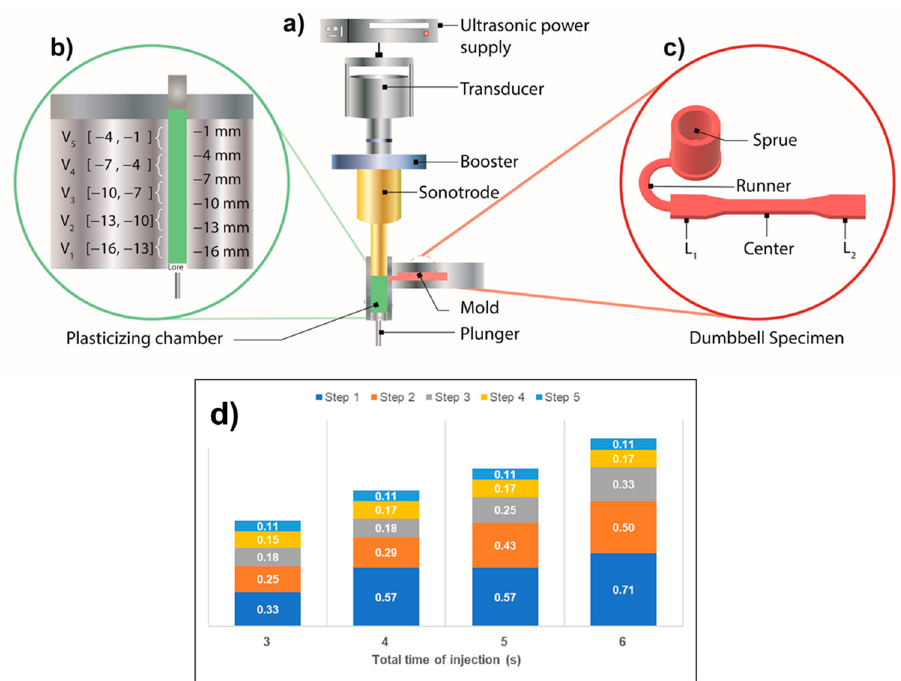
Figure 1. ( a ) Scheme of the UMIM machine; ( b ) injection distance in the plasticizer chamber, where the distances of the five steps are described; ( c ) dumbbell-shaped specimen obtained at the end of the UMIM process using a mold with the corresponding shape; and ( d ) bar graph showing in detail the inverse of the plunger displacement speed for each of the times selected in this study.